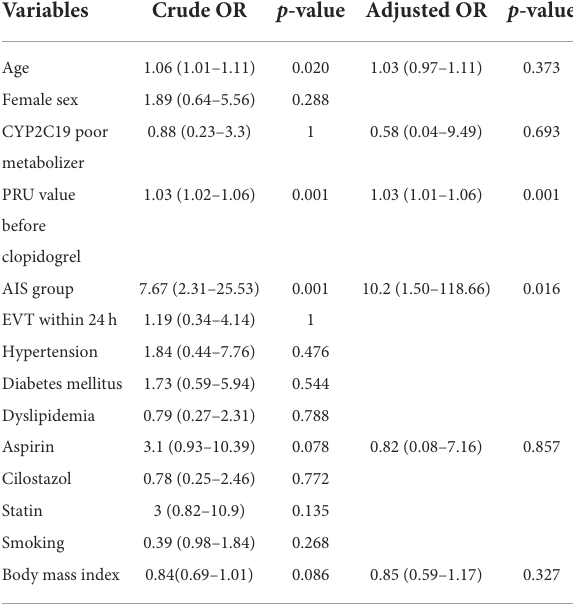
TABLE 2 Factors associated with clopidogrel